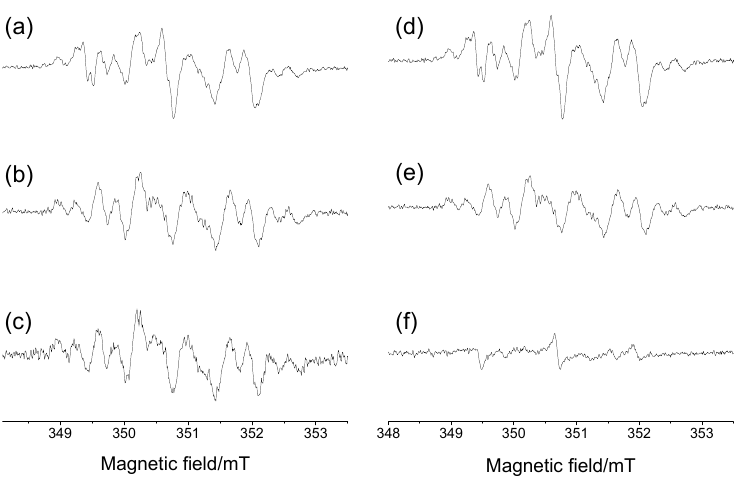
Figure 5. A time-dependent EPR spectrum recorded for a diluted and oxygen-free solution of HPN 22a in PhMe: ( a , d ) immediately after radical formation; ( b , e ) at 1 h after radical formation; ( c , f ) 2 h after radical formation. The figure shows spectra that are normalized to the maximum on the y -axis ( a , b ) as well as non-normalized spectra ( d – f ).